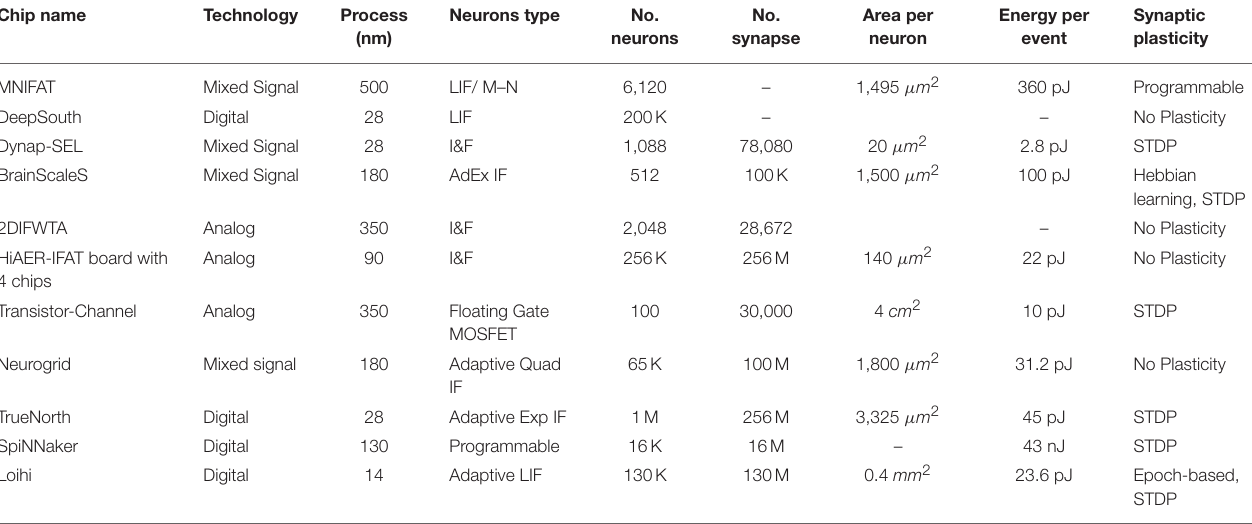
TABLE 5 | Comparison of event-based neural